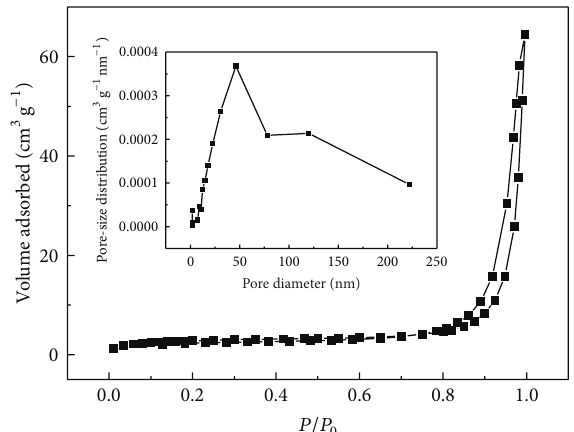
Figure 7: Nitrogen adsorption-desorption isotherms of carbyne polysulfide. The inset shows the pore-size